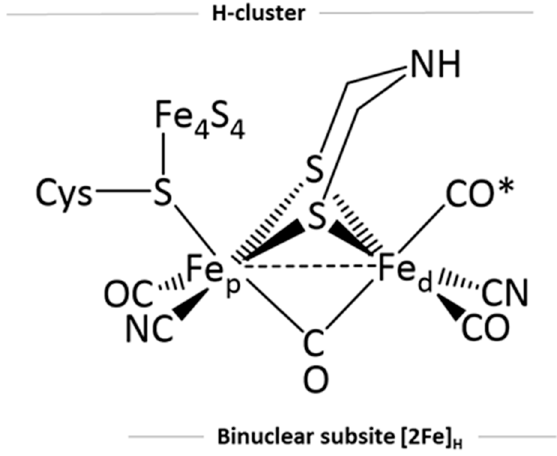
Figure 1. The active site of [FeFe]-hydrogenases, generally referred to as the H-cluster; its diiron portion “[2Fe] H ” directly involved in the binding of incipient substrates (H 2 and H + ) and inhibitors is highlighted. The carbonyl ligand marked with an asterisk represents an exogenous CO ligand behaving as an inhibitor. A cysteinyl sulfur bridges the diiron subsite with a [Fe 4 S 4 ] subsite that completes the H-cluster composition. The two Fe atoms of the diiron subsite are labeled with subscripts “d” (distal) or “p” (proximal), depending on their position with respect to the [Fe 4 S 4 ] subsite.